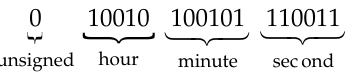
Figure 7. Data representation under GeoSOT-AS model. The logical modeling of ADS-B information records the code of the profile element at its spatial location, as well as the entity properties, and the 3D profile modeling of the point can be expressed by Equation (3): (cid:4688) 𝑃 (cid:3002)(cid:3020)(cid:2879)(cid:3046)(cid:3048)(cid:3029)(cid:3031)(cid:3036)(cid:3049)(cid:3036)(cid:3046)(cid:3036)(cid:3042)(cid:3041) = 𝐶𝑂𝐷𝐸 (cid:3041) (cid:3034) (cid:4653)⎯(cid:4654) 𝑆𝑈 𝐶𝑂𝐷𝐸 (cid:3041) = 𝑓(𝐿, 𝐵, 𝐻, 𝑇) 𝐴 (cid:3043) = 𝐴 (cid:3046)(cid:3048)